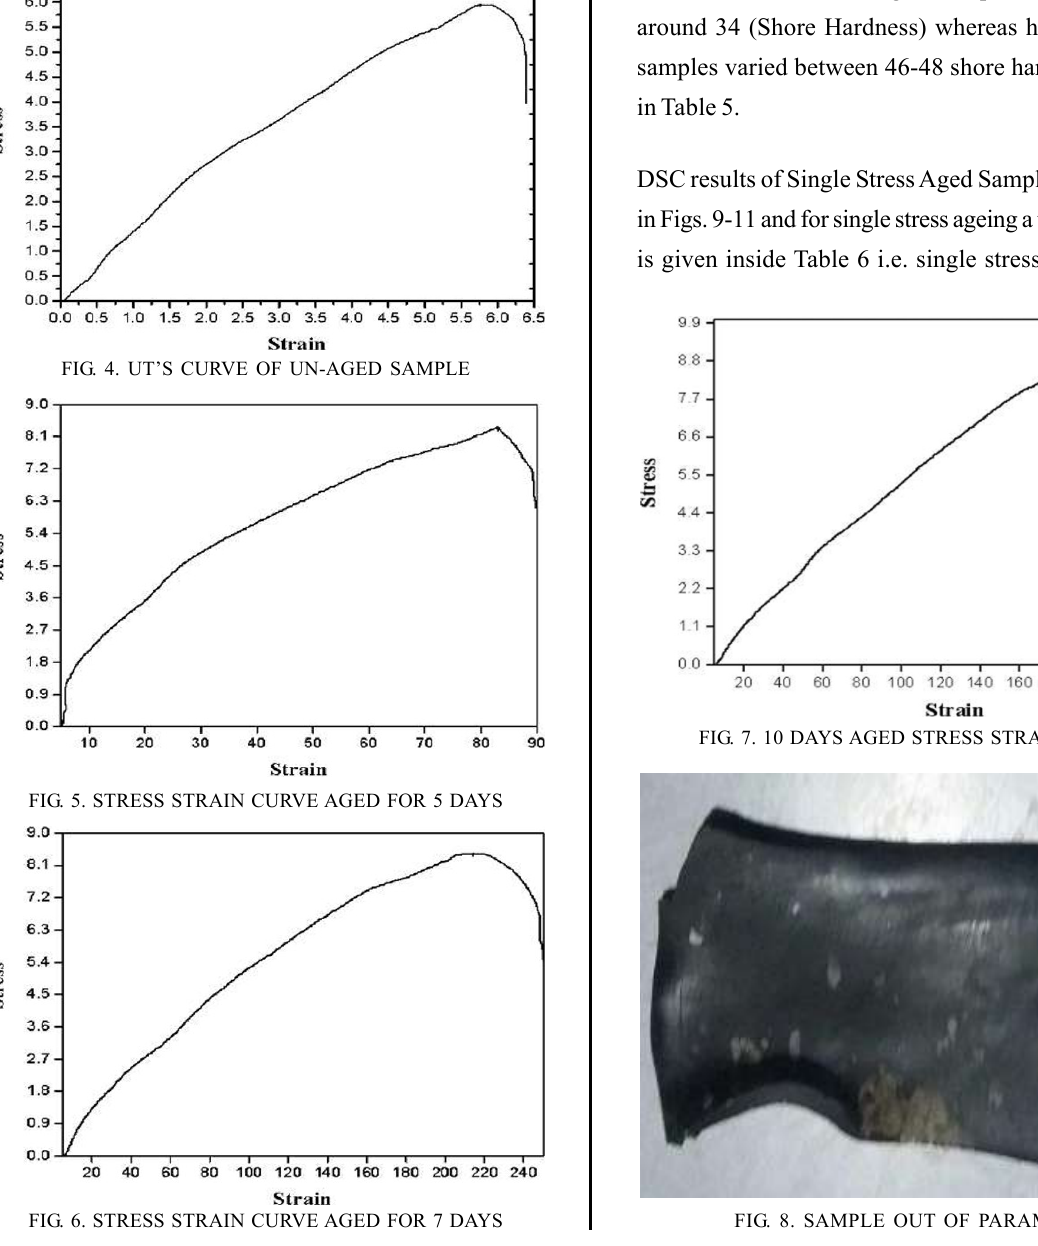
FIG. 6. STRESS STRAIN CURVE AGED FOR 7 DAYS